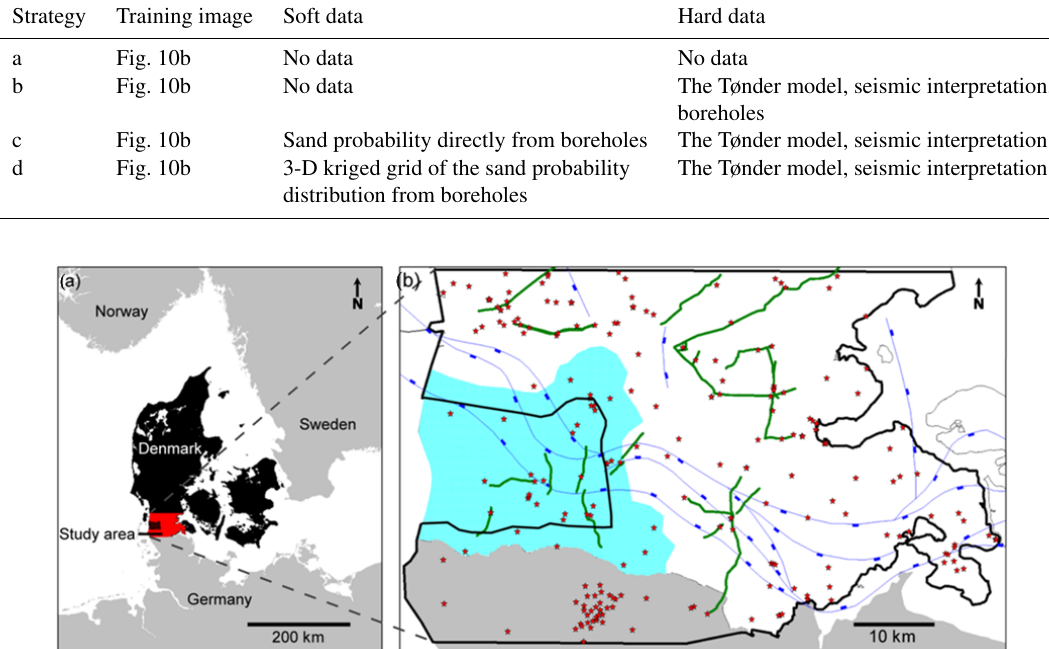
Figure 2. (a) Location of the study area and (b) map of the model area (the solid black line) shown together with the data and the fault structures delimiting the Tønder graben: red stars indicate boreholes deeper than 100m, green lines the position of the seismic lines, and the Tønder graben structure is marked in blue (Ter-Borch, 1991). The turquoise shading marks the model area of the Tønder model (Jørgensen et al., 2015); the grey zone in map (b) represents